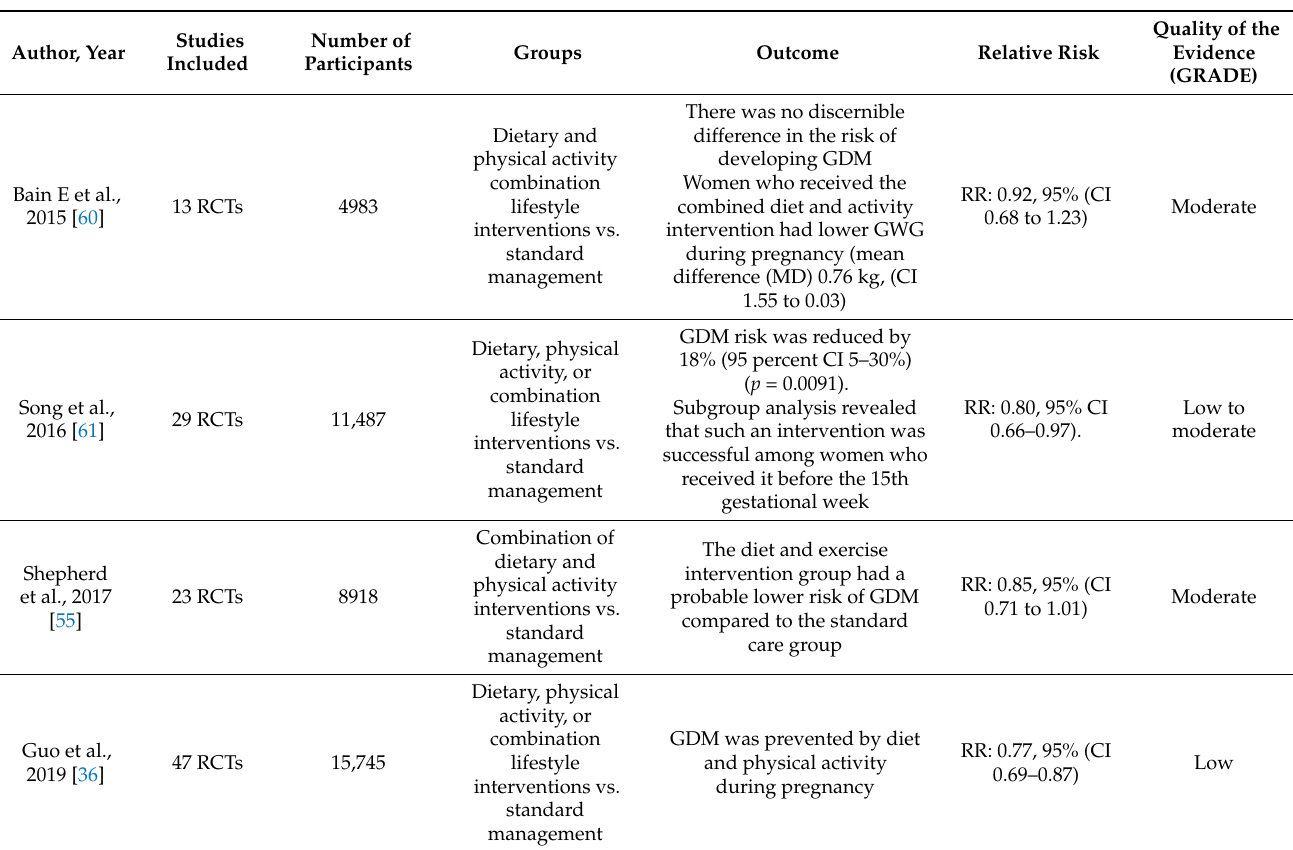
Table 2. Summary of meta-analysis on the effect of lifestyle interventions (combination of dietary changes and physical